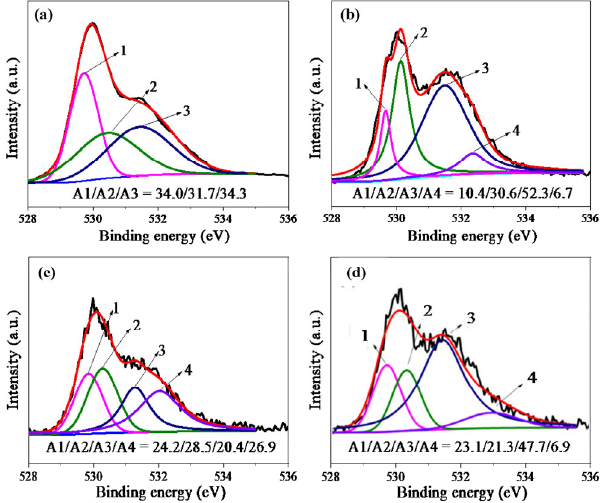
Fig. 16 XPS spectra of O 1s of the rubbed surfaces lubricated by PAO6 containing different mass concentrations of TiO 2 /BP nanocomposites under the load of 20 N: (a) 0%, (b) 0.005%, (c) 0.01%, and (d)